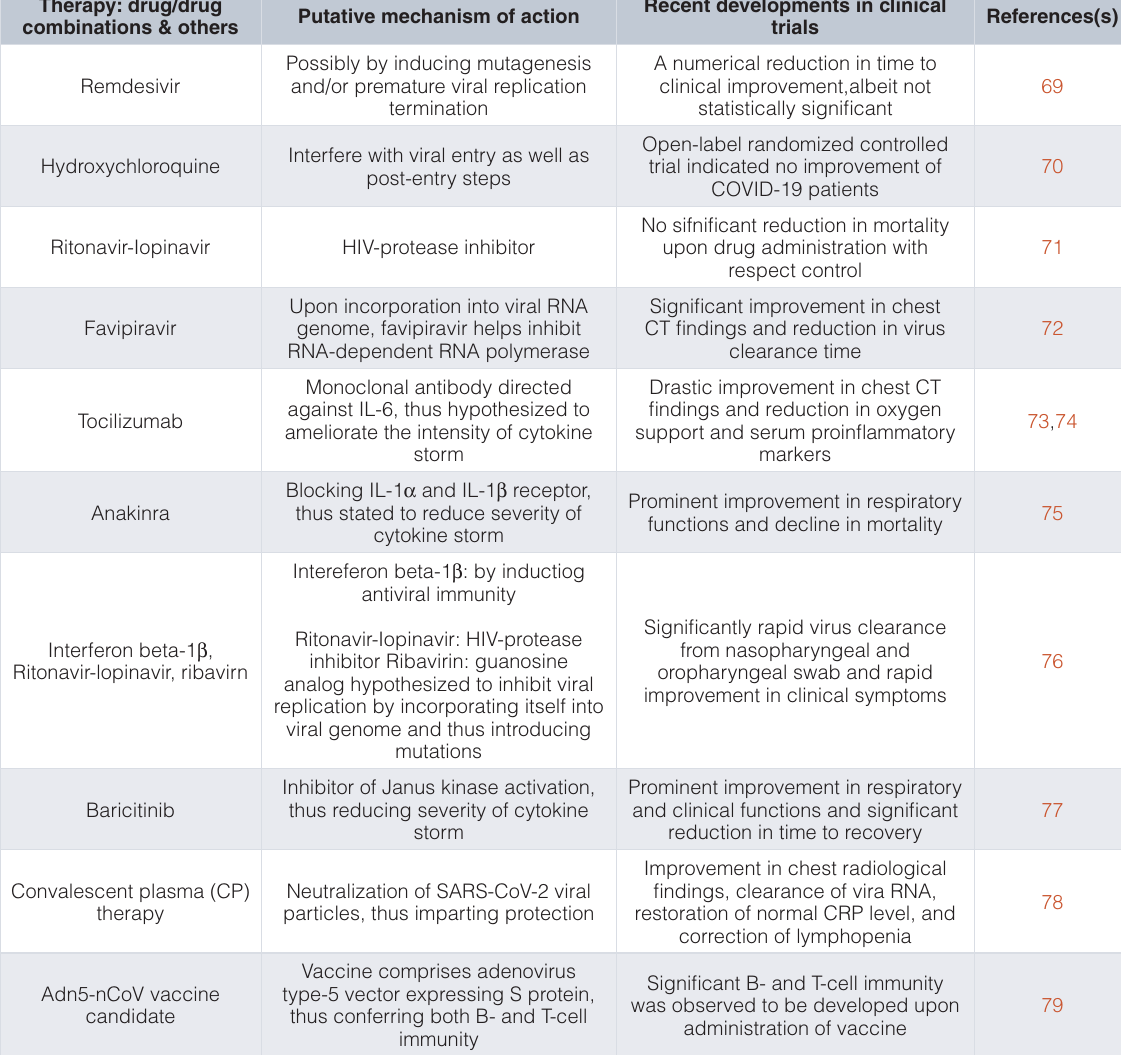
Table 1. Summary of the major therapeutic strategies under clinical trial, their respective preliminary outcomes, and the putative mechanisms behind their actions. Therapy: drug/drug combinations &